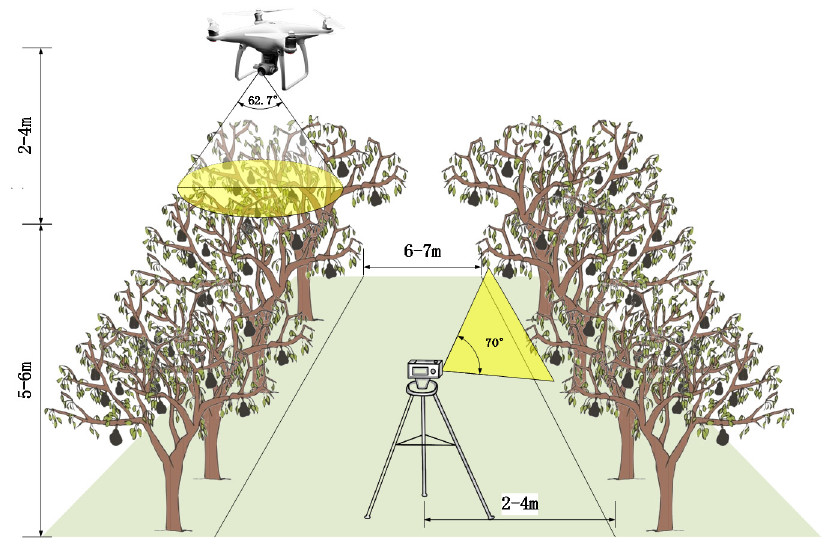
Figure 2. Schematic illustration of joint data acquisition.